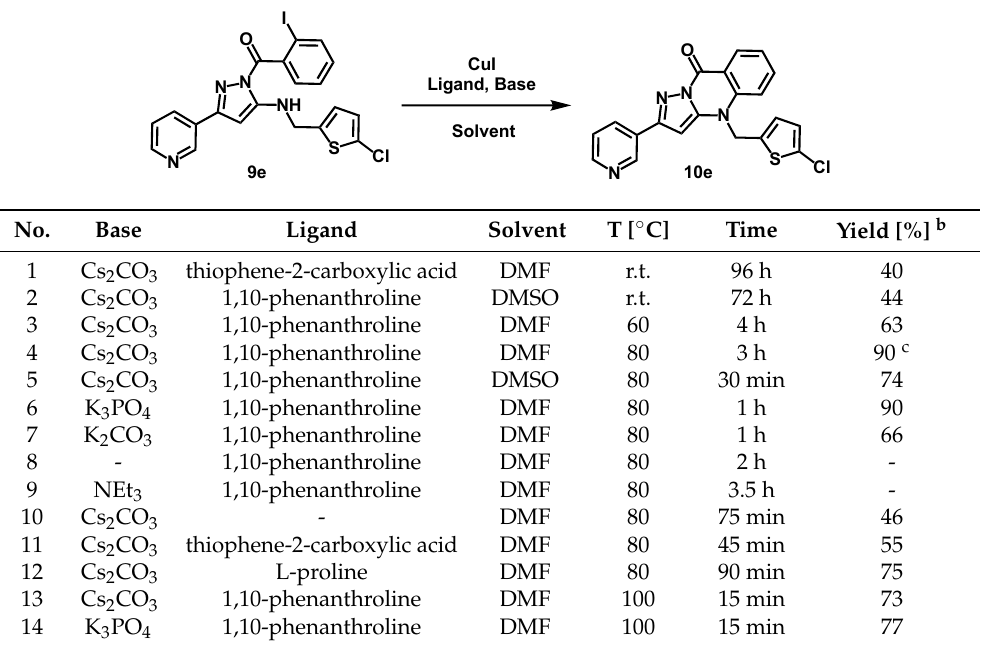
Table 1. Optimization of the model reaction a .